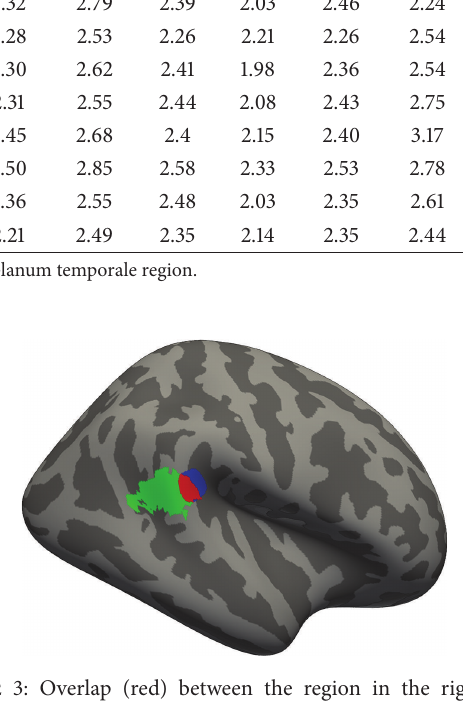
Figure 3: Overlap (red) between the region in the right PTR where cortical thickness predicts visual motion detection thresholds (blue + red) and a region of visual motion-related cross-modal activity in deaf people from Shiell et al. (2015) [25] (green +